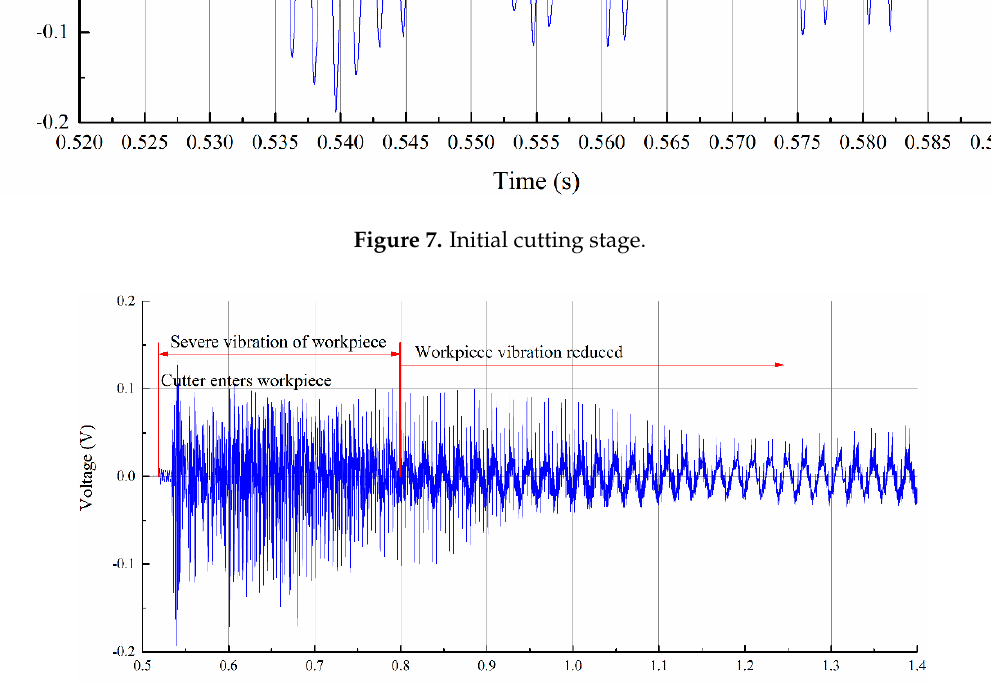
Figure 8. Transition from the vibration stage to the stable cutting stage.